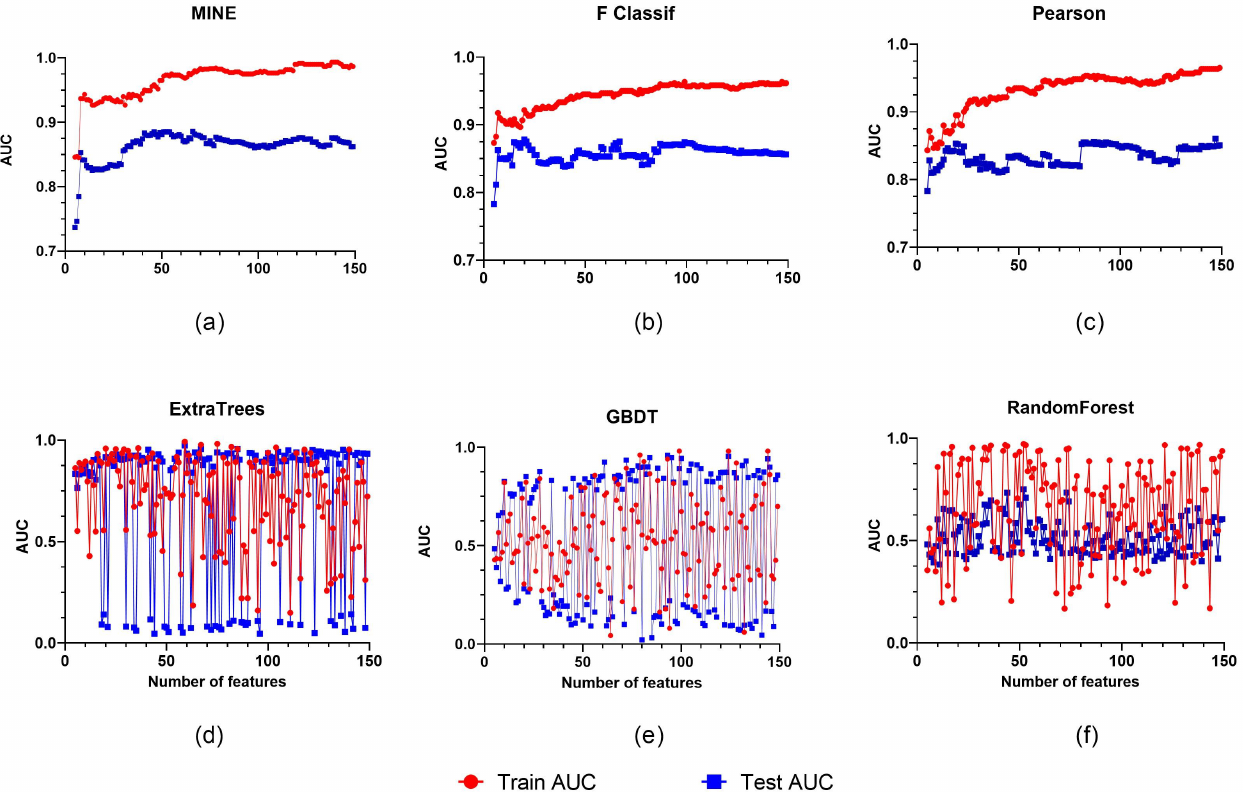
Figure 4. Six different feature screening approaches are illustrated, with the horizontal coordinate showing the number of features selected and the vertical coordinate showing the classifier’s AUC. The filtered scheme includes ( a – c ). The embedded scheme includes ( d – f ).